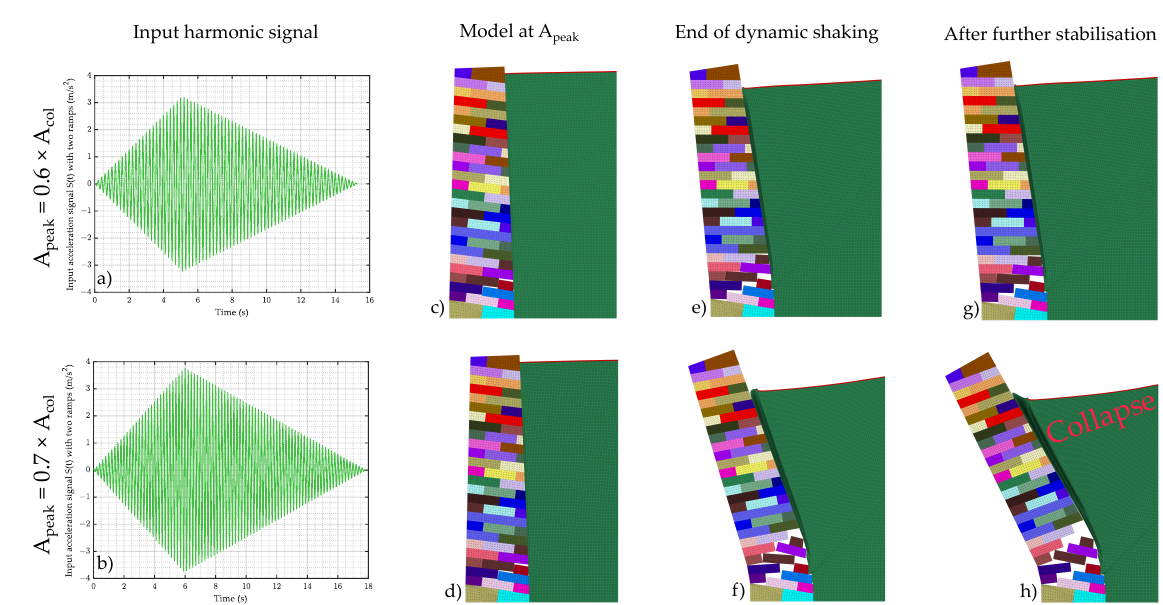
Figure 14. Evaluation of the ratio between A peak and A col for DSRW1: ( a ) dynamic input signal with A peak = 0.6 × A col ; ( b ) dynamic input signal with A peak = 0.7 × A col ; ( c , d ) models at A peak ; ( e , f ) models at the end of the dynamic input; ( g , h ) computation of the post-seismic static